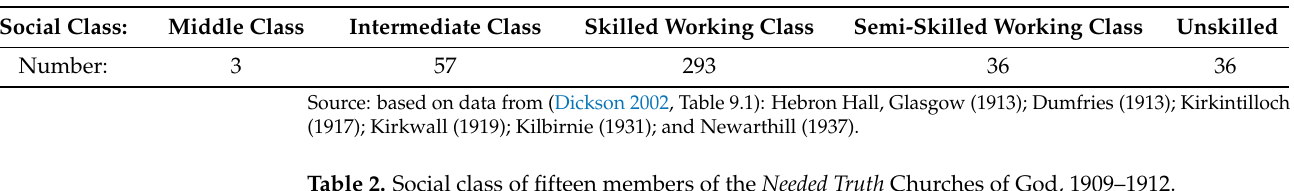
Table 1. Social class in six Scottish Open Brethren assemblies, 1913–1937.